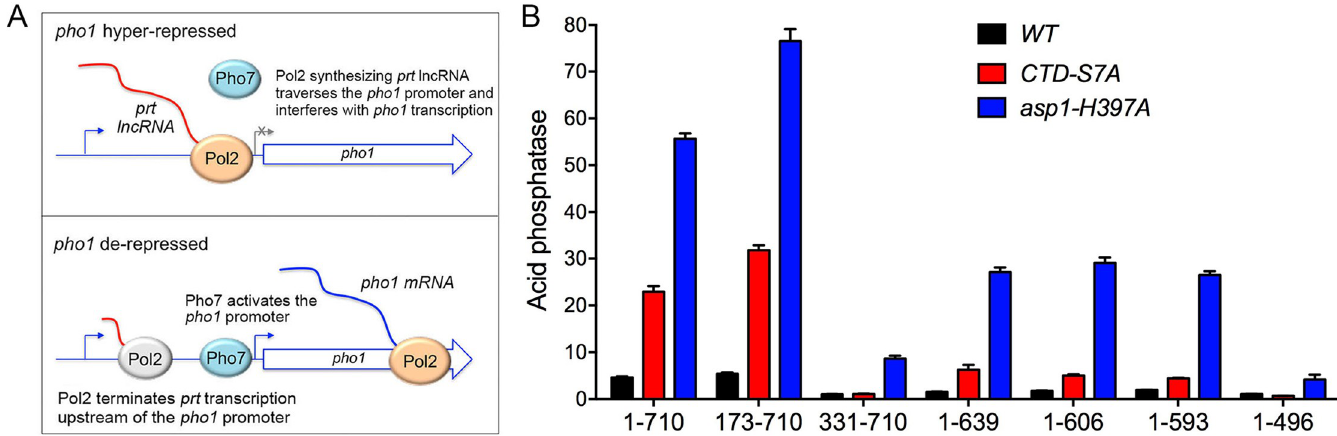
Fig 10. Effect of Ppn1 truncations on phosphate homeostasis. (A) Top panel. Decreased termination of prt lncRNA synthesis increases interference with the pho1 mRNA promoter and hyper-represses Pho1 expression in phosphate-replete cells. Bottom panel. Precocious termination of prt lncRNA synthesis upstream of the pho1 mRNA promoter results in de-repression of Pho1. See text for discussion. (B) S . pombe strains bearing the ppn1 alleles shown on the x-axis, in an otherwise wild-type background (WT) or in the context of the pho1 de-repressive rpb1-CTD-S7A or asp1-H397A mutations, were grown in liquid culture at 30˚C and assayed for acid phosphatase